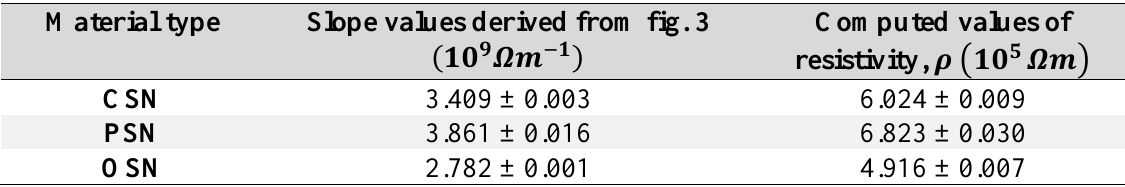
Table 3. Summary of resistivity values obtained at (25.0 ±